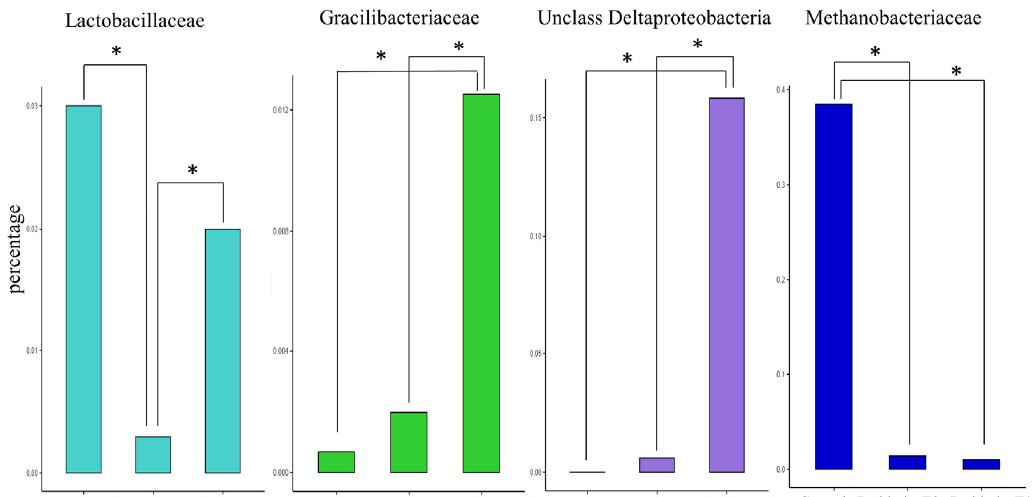
Figure 6. Statistical significant differences in families relative abundance among Control, Probiotic T0 and Probiotic T1 groups. The * indicates p < 0.01. Supporting information on relative abundance and p -values is found in Tables S6 and S7.